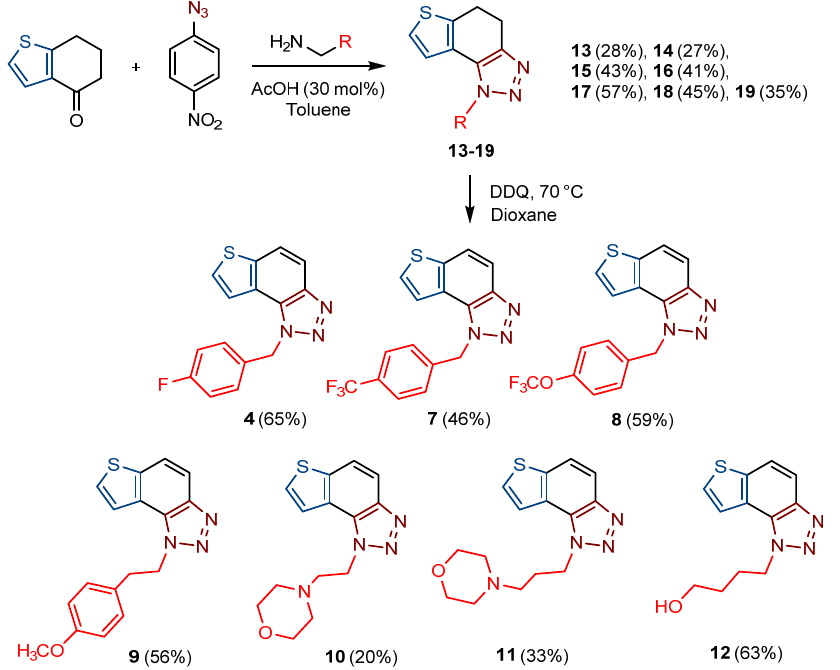
Scheme 2. Reaction pathway for the synthesis of thienobenzo-triazoles 4 , 7 – 12 and their